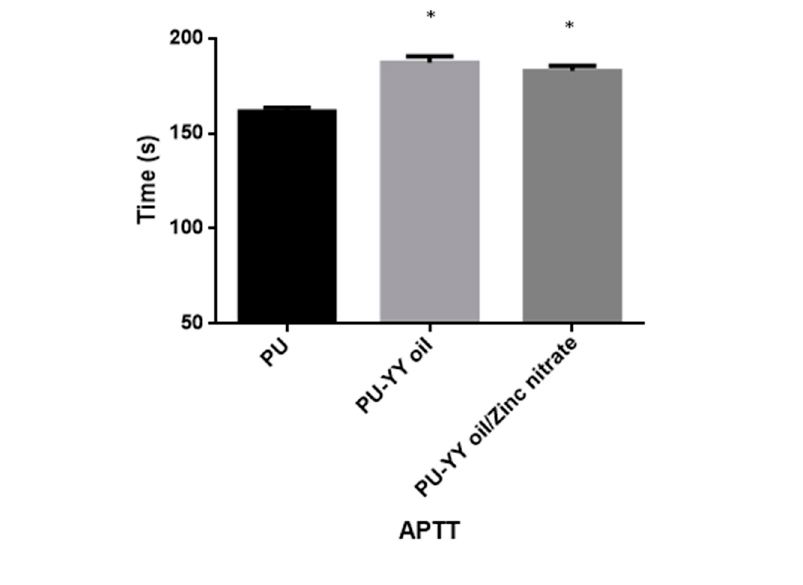
Figure 9. Activated Partial Thromboplastin Time (APTT) assay of PU, PU/YY and PU/YY/ZnNO 3.